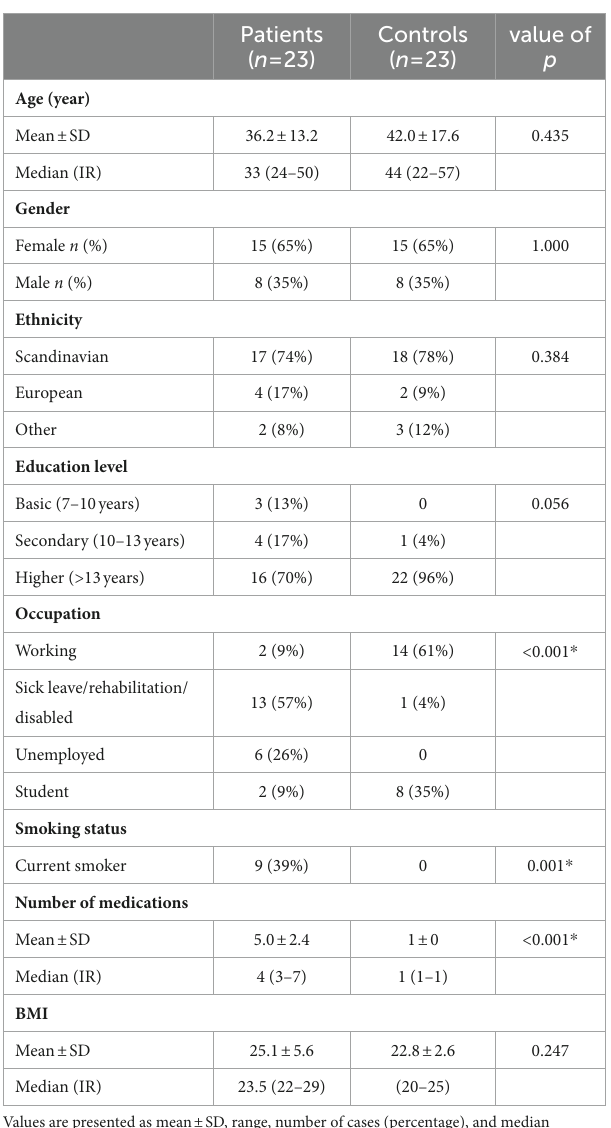
TABLE 1 Characteristics of the patients and healthy